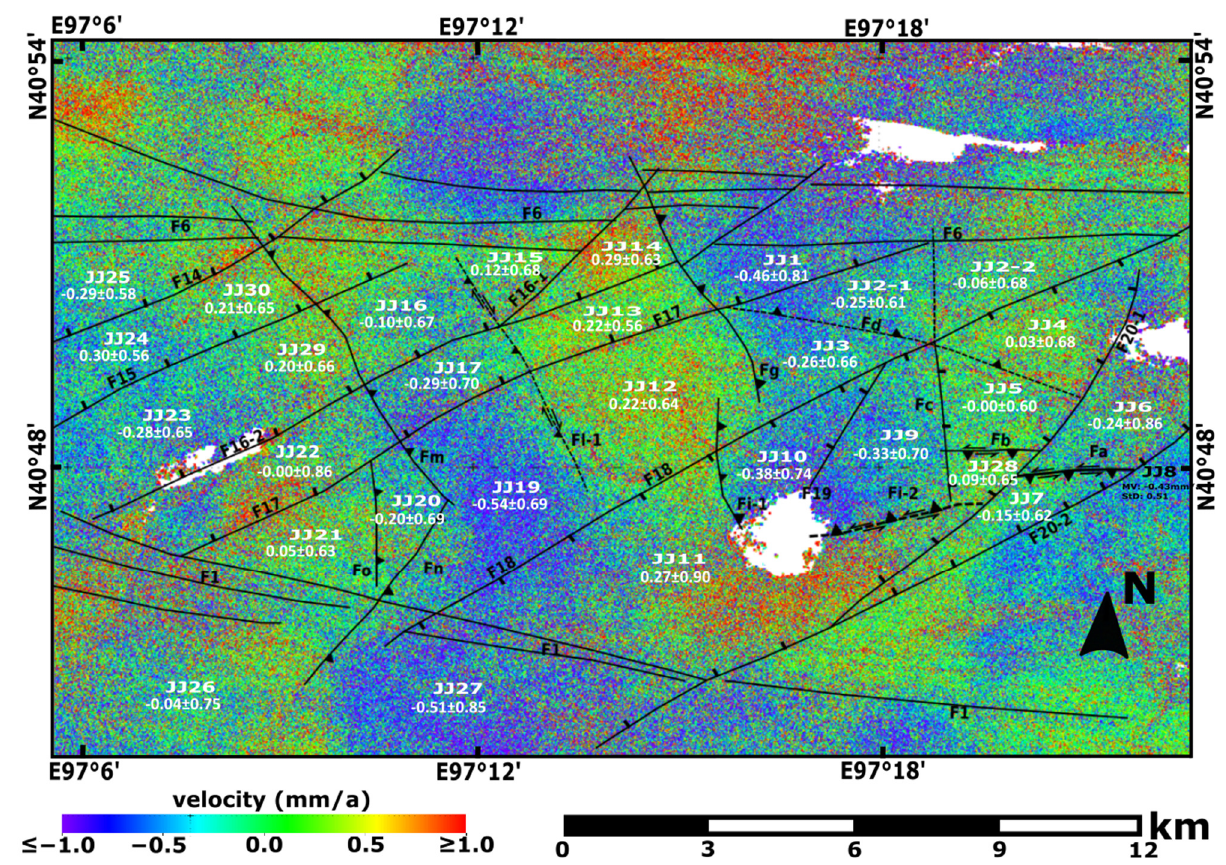
Figure 7. The pattern of horizontal deformation (D E ) in the Jiujing region, where the positive values (red- and yellow-coloured) refer to eastward horizontal displacements and the negative values (blue-coloured) refers to westward displacements. Values in white text indicate movement rates with standard deviations in mm a − 1 and the full data are presented in Table S2 in Supplementary Materials.